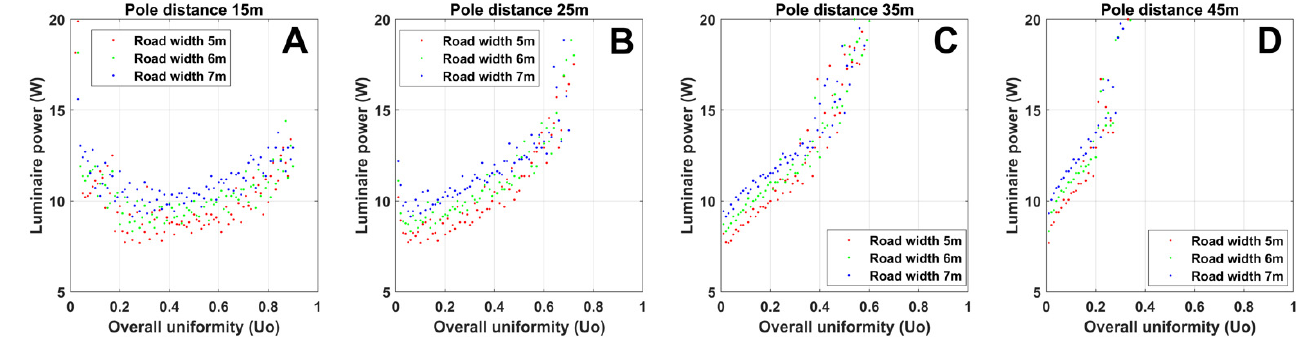
Figure 5. Overall uniformity of illuminance vs. minimum luminaire power for E m = 10 lx for key pole distances: ( A ) results for pole distance of 15 m; ( B ) results for pole distance of 25 m; ( C ) results for pole distance of 35 m; ( D ) results for pole distance of 45 m.